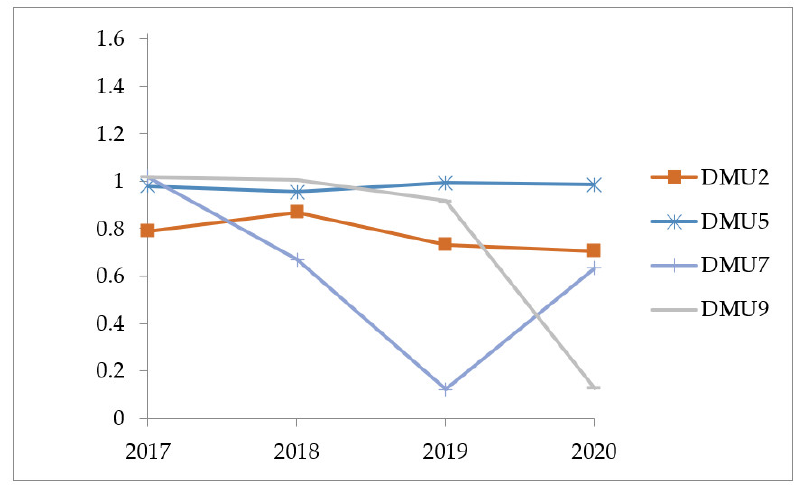
Figure 9. Adjusted Malmquist index (AMI)